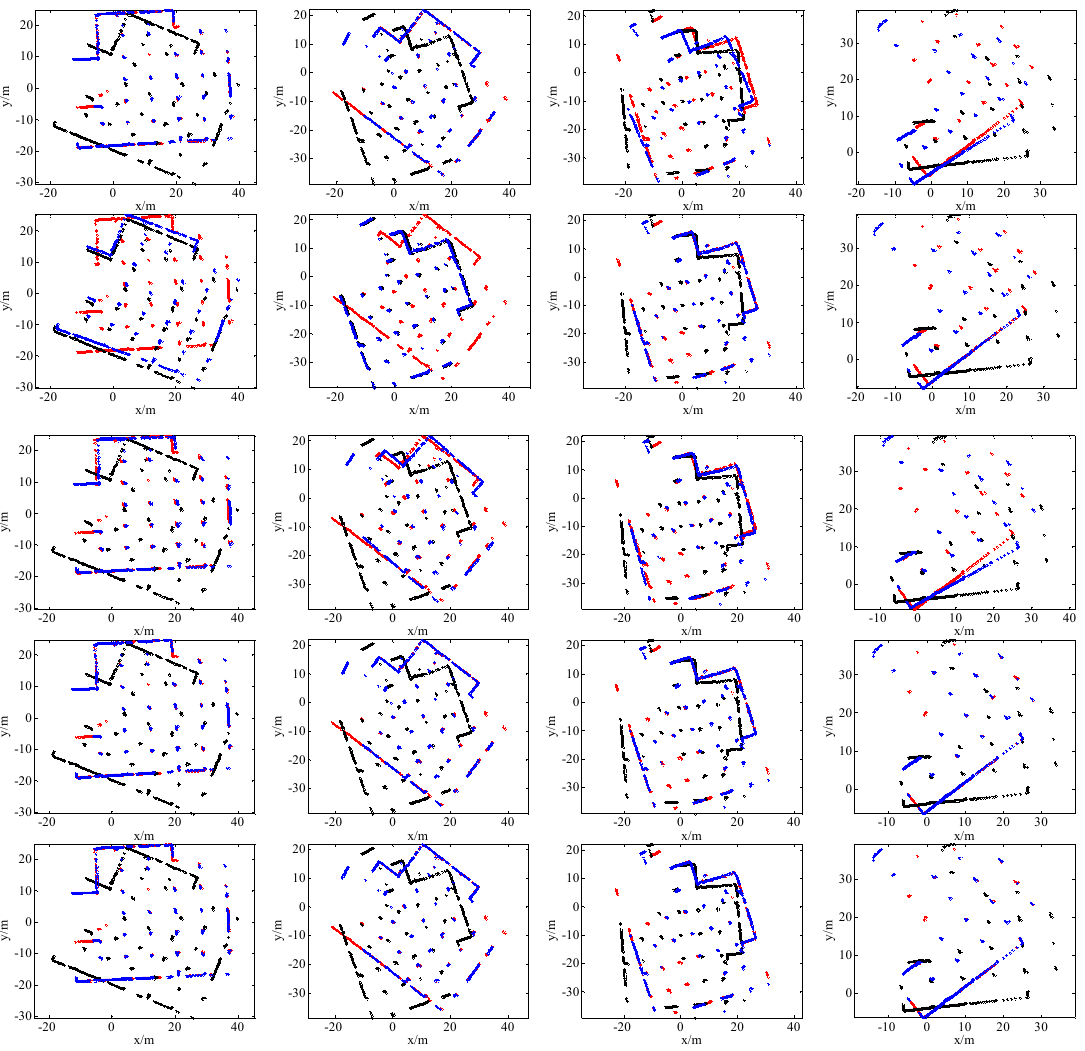
Figure 8. Some scan matching results of dataset 2. The first row is the results of PSM; the second row is the results of PLICP; the third row is the results of ICP without an initial guess (ICP 1 ); the fourth row is our scan matching results; the last row is the results of ICP with a good initial guess (ICP 2 ). In all of these plots, the points denoted by red +, black +, and blue + represent the first laser scan S k -1 , the